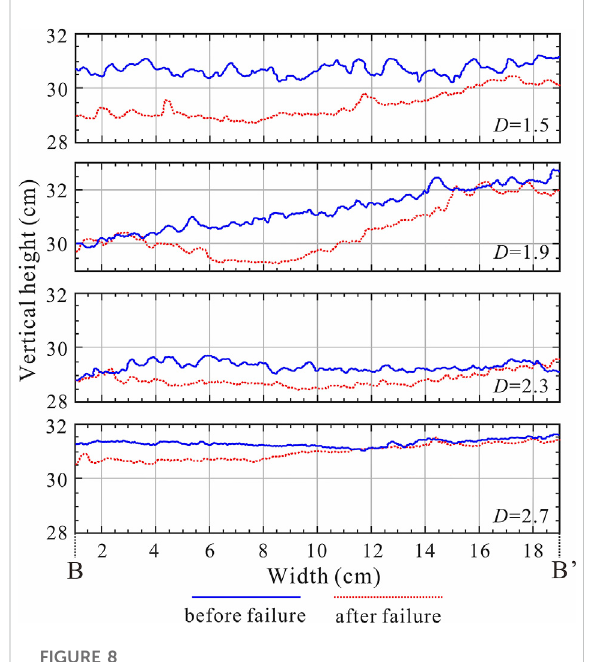
FIGURE 8 Transverse sections for granular slopes with different fractal dimensions before and after sur fi cial failure.